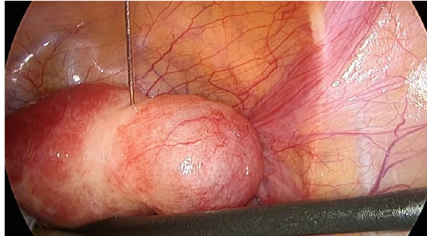
Figure 5: Incision was closed using continuous barbed mono fi lament